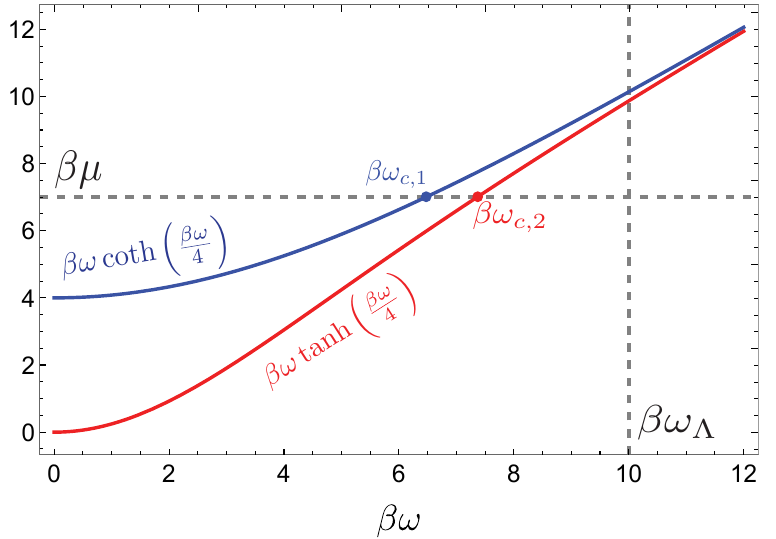
Figure 10 . Di(cid:11)erent regimes of eq. (4.1): values of (cid:12)(cid:22) above the blue curve, i.e. (cid:12)! coth( (cid:12)!= 4), correspond to the (cid:12)rst regime in this equation; below the red curve i.e. (cid:12)! tanh( (cid:12)!= 4), correspond to the third regime; while between the blue and red curves correspond to the second regime. We observe that when (cid:12)(cid:22) (cid:29) 1, there is a very narrow range of frequencies (cid:12)! between the blue and red lines (since both curves converge towards (cid:12)! ) for which the intermediate regime